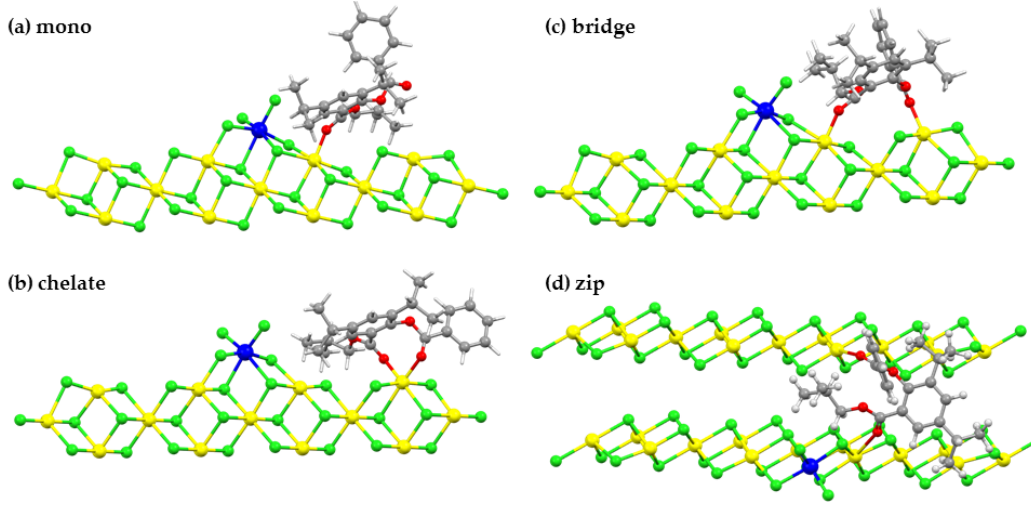
Figure 2. Four different adsorption modes, ( a ) mono, ( b ) chelate, ( c ) bridge, and ( d ) zip of the salicylate donor (SID-4) on the Ziegler–Natta (ZN) catalyst. Color key: Mg, yellow; Ti, blue; Cl, green; O, red; C, gray; H, white.